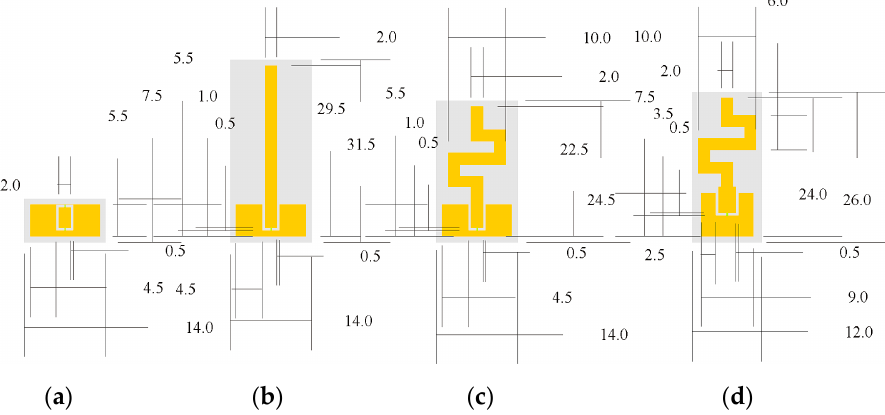
Figure 2. A top view of configurations of the CPW and antennas during the design process: ( a ) coplanar waveguide; ( b ) monopole antenna; ( c ) monopole antenna based on the Minkowski curve; ( d ) proposed antenna. All dimensions are in mm.